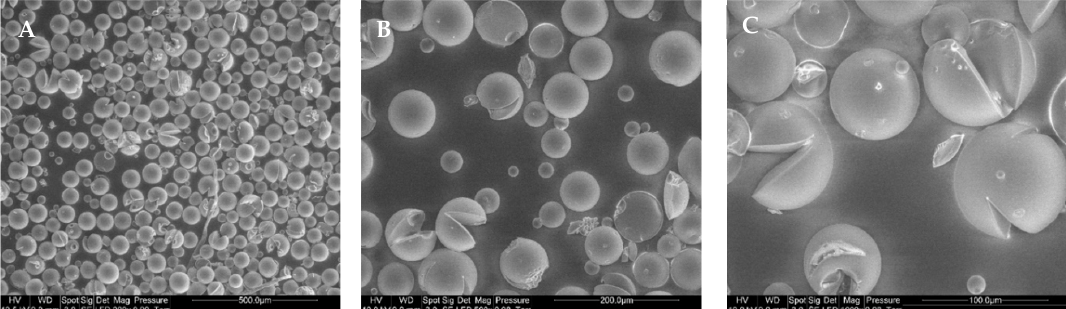
Figure 4. Scanning electron microscopy pictures of Suspension synthesized MIP with 2024 g ∙ L − 1 of polyvinyl alcohol. The pictures have been zoomed in 200 times ( A ), 500 times ( B ), and 1000 times ( C ).